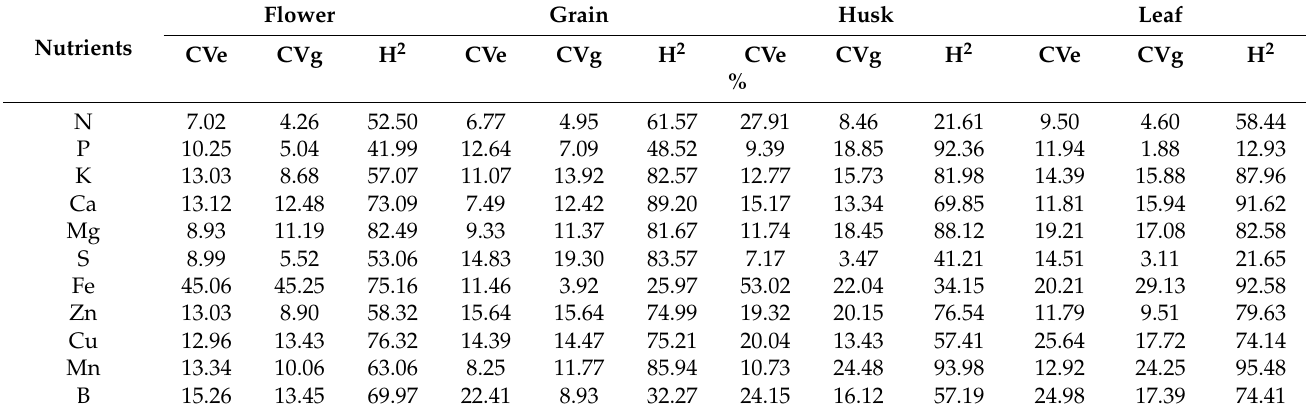
Table 2. Estimates of the experimental coefficient of variation (CVe), coefficient of genetic variation (CVg), and genotypic determination coefficient (H 2 ) for nutrient concentrations in the flowers, grains, husks, and leaves of 16 Coffea canephora genotypes. Alta Floresta D’Oeste, RO,